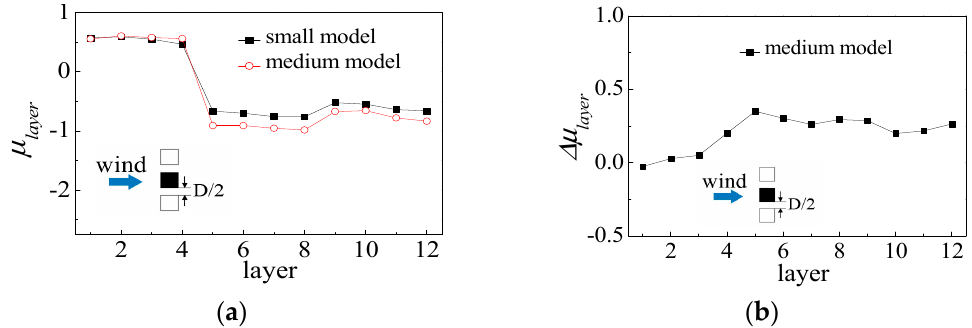
Figure 11. Wind tunnel test results of test condition 1. ( a ) Layer pressure coefficient; ( b ) relative error of layer pressure coefficient.